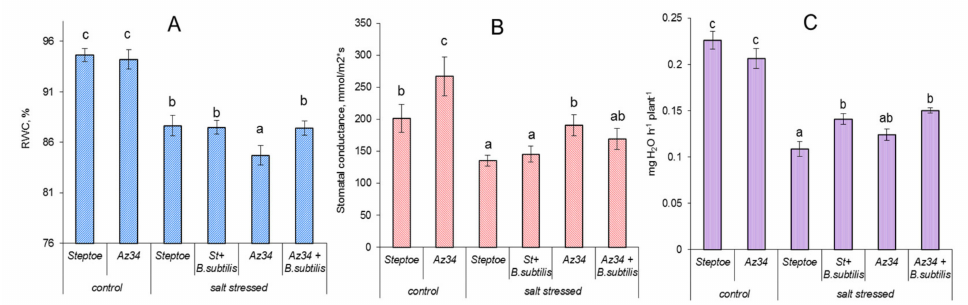
Figure 2. Influence of B. subtilis IB-22 on the relative water content in the leaves ( A , n = 5) stomatal conductance ( B , n = 40) and transpiration ( C , n = 5) of control (unstressed) and salt-stressed (100 mM NaCl) ABA-deficient barley mutant (Az34) and its parental cultivar Steptoe measured on the 8th day after bacterial treatment. Significantly different means for each variable are labeled with different letters at p ≤ 0.05.